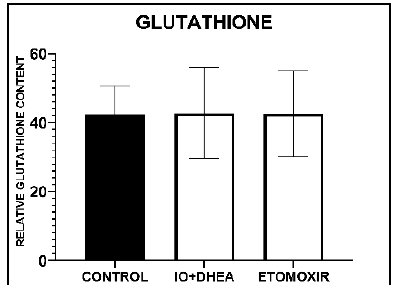
Figure 2. The effect of glucose (IO+DHEA) and fatty acid (ETOMOXIR) metabolism inhibition on glutathione content in mature oocytes (means ± SD).